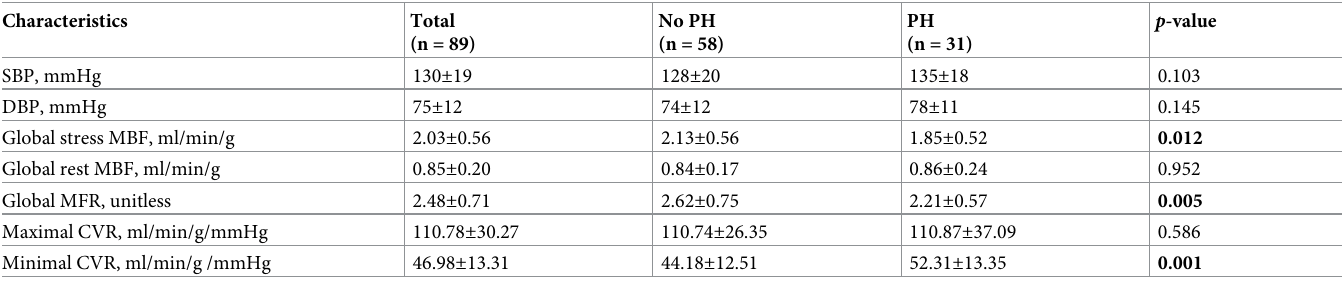
Table 2. Global PET parameters of HCM patients with and without